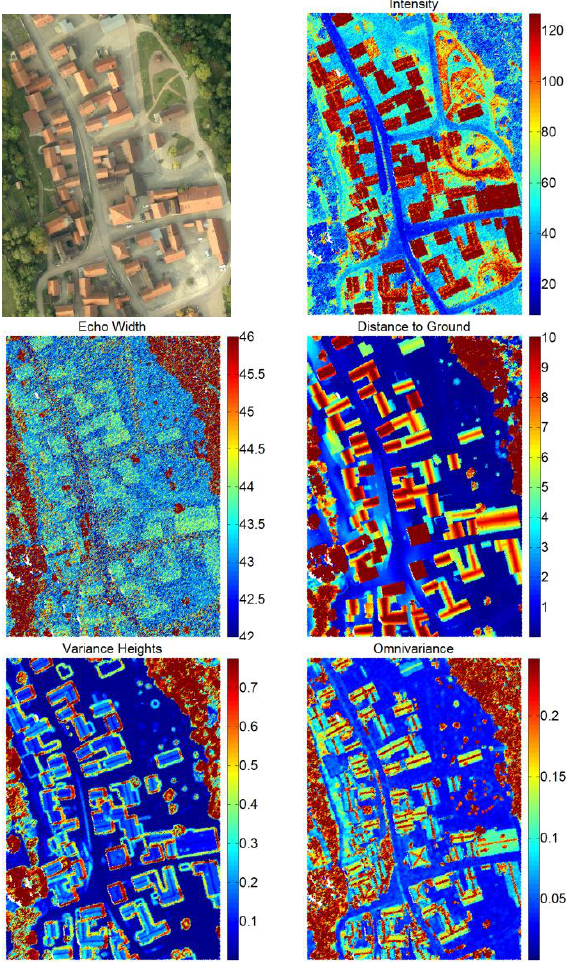
Fig. 2: Sampled feature characteristics in different object classes. Plots show a) aerial image as reference, b) amplitude, c) echo width, d) distance to ground, e) variance of heights and f)